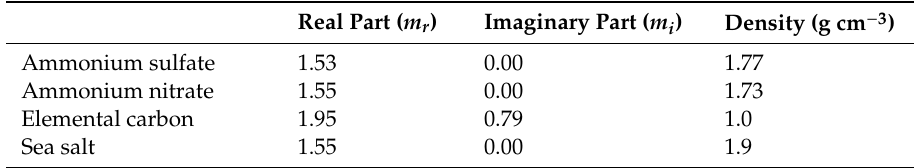
Table 1. Aerosol refractive indices ( m r + im i ) at a wavelength of 550 nm [5,6] and densities for external mixing. Real Part ( m r ) Imaginary Part ( m i ) Density (g cm − 3 ) Ammonium sulfate Elemental